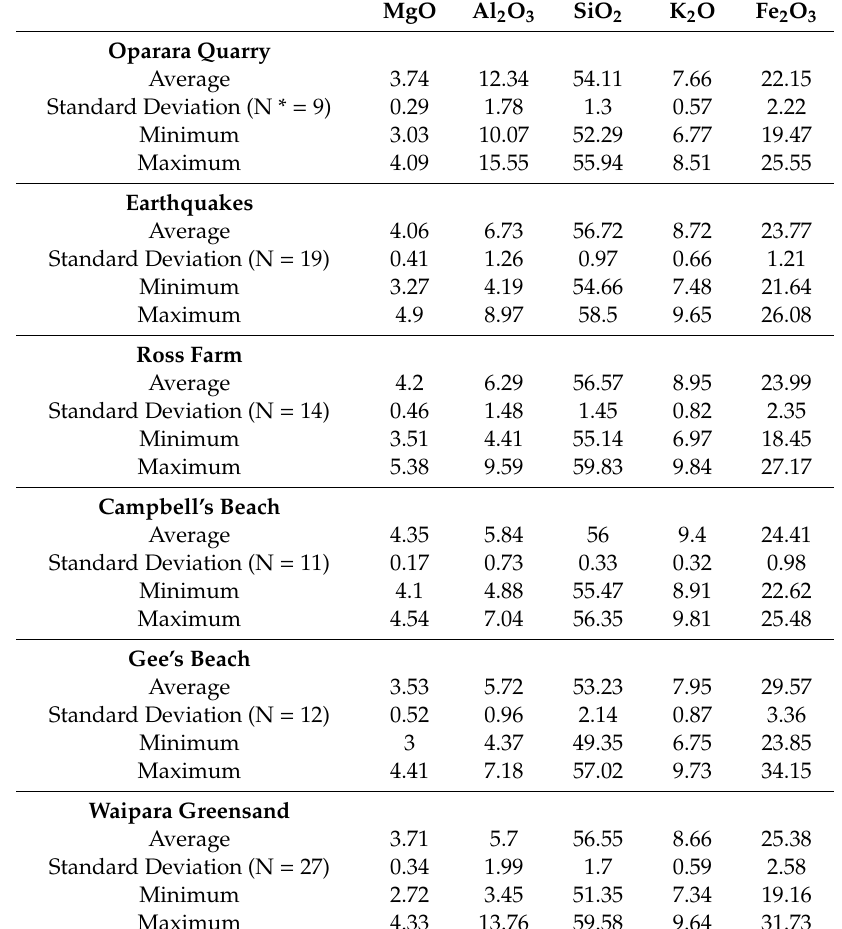
Table 3. Average, standard deviation, maximum, and minimum concentrations for all grains measured by